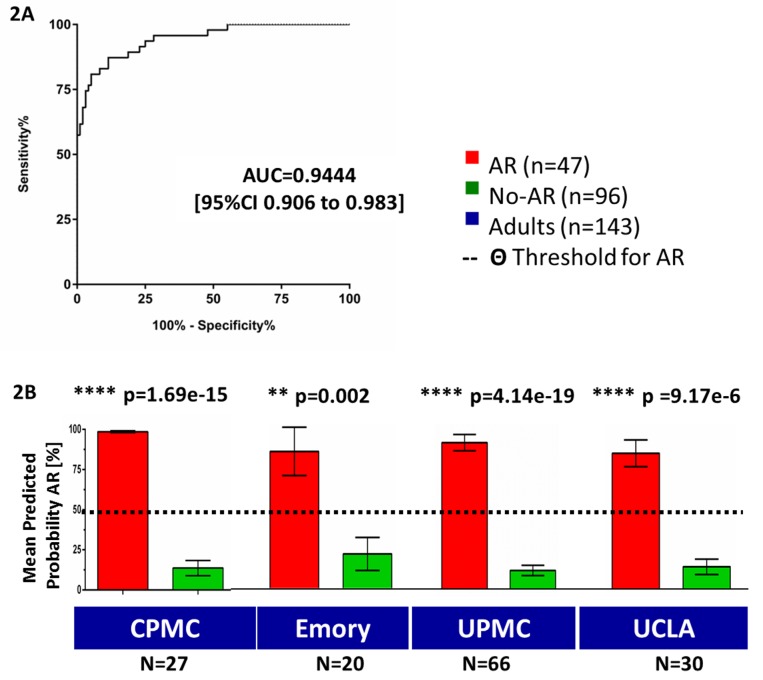
Training of a 17-gene model (kSORT) for acute rejection classification in 143 adult samples from real-life settings.17 genes were used to classify 143 adult blood samples from four different sites into AR and No-AR by plsDA (threshold for AR prediction Θ was set at Θ = 50%). (A) AUC for AR in the training set was 0.94 (95% CI 0.91–0.98). (B) Predicted probabilities of AR were significantly higher in AR samples versus No-AR samples for each collection site and did not reach the threshold for AR prediction in the No-AR samples (predicted probability threshold Θ; Θ≥50%). Mean predicted probabilities for AR were 98.6%, 75.9%, 86.8%, and 77.2% for CPMC, Emory, UPMC, and UCLA, respectively. Mean predicted probabilities for No-AR were 13.7%, 19.4%, 11.3%, and 12.8% for CPMC, Emory, UPMC, and UCLA, respectively. Graphs show mean predicted AR probabilities in percent plus standard error of mean; p-values were calculated by two-sided Student's t test with Welch correction in case of unequal variances.